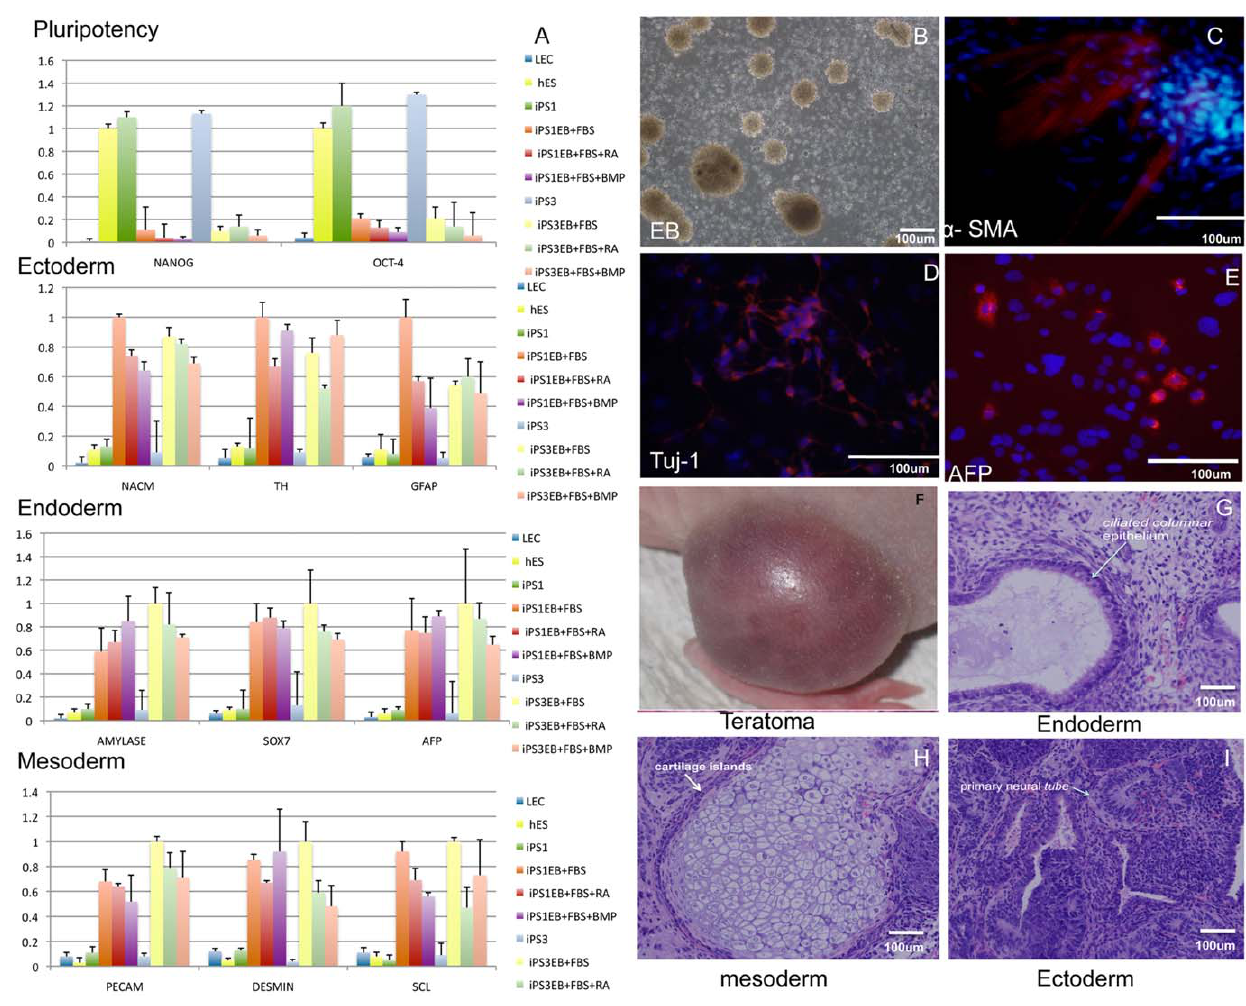
Figure 3. The pluripotency of HLEC-iPS cells and up-regulation of ectodermal, endodermal, and mesodermal markers. (A) Real-time RT-PCR analyses of pluripotency gene expression levels in iPS and control HESCs (H9) induced to differentiate via embryoid body (EB) formation and subsequent plating under the indicated conditions (BMP4, FBS, and retinoic acid (RA)). The results were determined relative to GAPDH expression. The y-axis represents the relative fold change upon differentiation. The expression of marker genes for different germ layers was analyzed. The specificity of each marker for a given germ layer is indicated. (B) Phase-contrast images of EBs generated from iPS1 clones plated onto adherent tissue culture dishes. (C–E) EB-dissociated cells stained by immunofluorescence for mesodermal (C: a -smooth muscle actin ( a - SMA)), ectodermal (D: Tuj-1), or endodermal (E: AFP) markers representing each embryonic germ layer. Hematoxylin and eosin staining of teratoma sections from iPSC-derived teratomas is shown (F–I). (F) human iPSCs formed teratomas. (G) ciliated columnar epithelium (endoderm). (H) Cartilage islands (mesoderm). (I) primary neural tube (ectoderm).